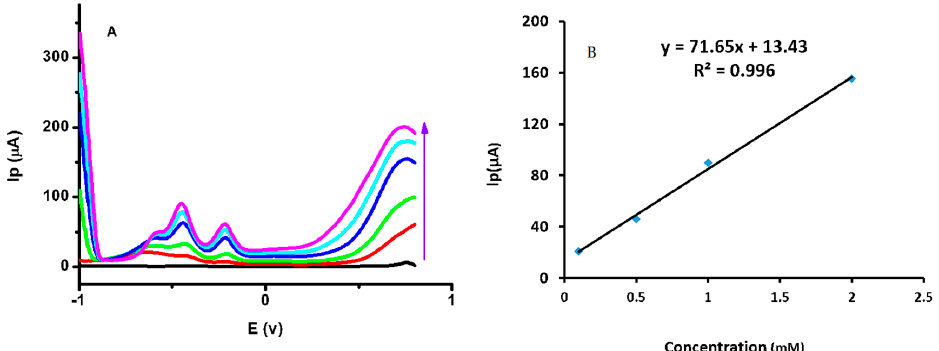
Figure 8. ( A ) Differential pulse voltammograms for different glucose concentrations (0.1 mM, 0.5 mM, 1 mM, 2 mM, and 2.5 mM); ( B ) A calibration plot of Ip versus glucose concentration.